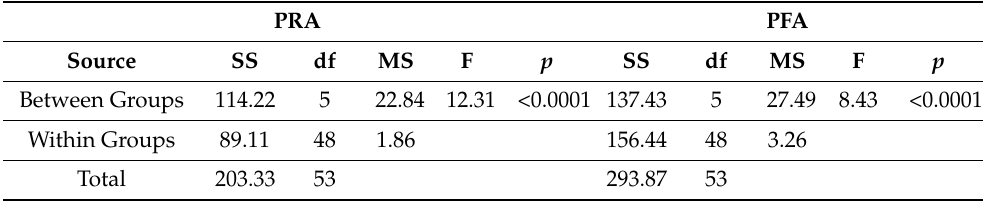
Table 5. ANOVA for leaf area of Vigna aconitifolia under different ANE treatments. PRA PFA Source